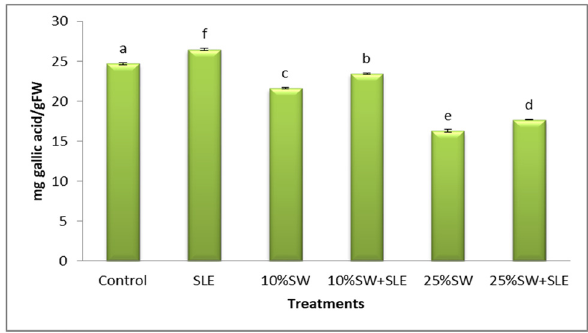
Figure 6: E ff ect of SLE on the phenol contents of T. aestivum L. grown under salt stress. Control – tap water, SW – seawater, SLE – spirulina liquid extracts 2%. The di ff erent letters are signi fi cant ( P ≤ 0.05 ) according to Duncan ’ s multiple range tests.